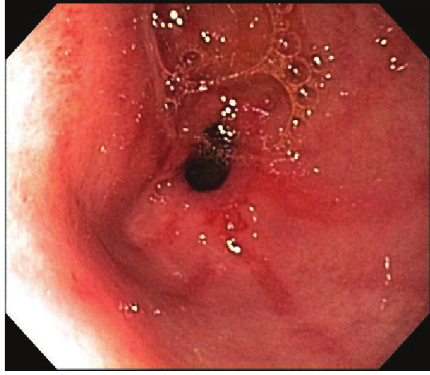
Figure 1: “Watermelon stomach” on upper endoscopy.